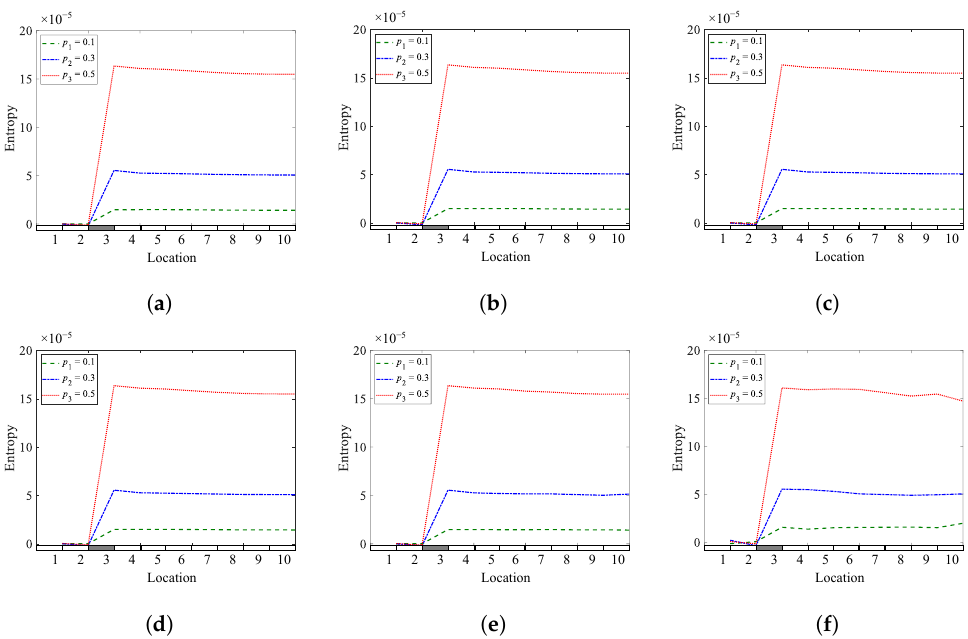
Figure 37. The effect of noise levels on Shannon entropy of a cantilever beam: ( a ) Noise-free; ( b ) SNR = 85 dB; ( c ) SNR = 65 dB; ( d ) SNR = 45 dB; ( e ) SNR = 25 dB; ( f ) SNR = 10